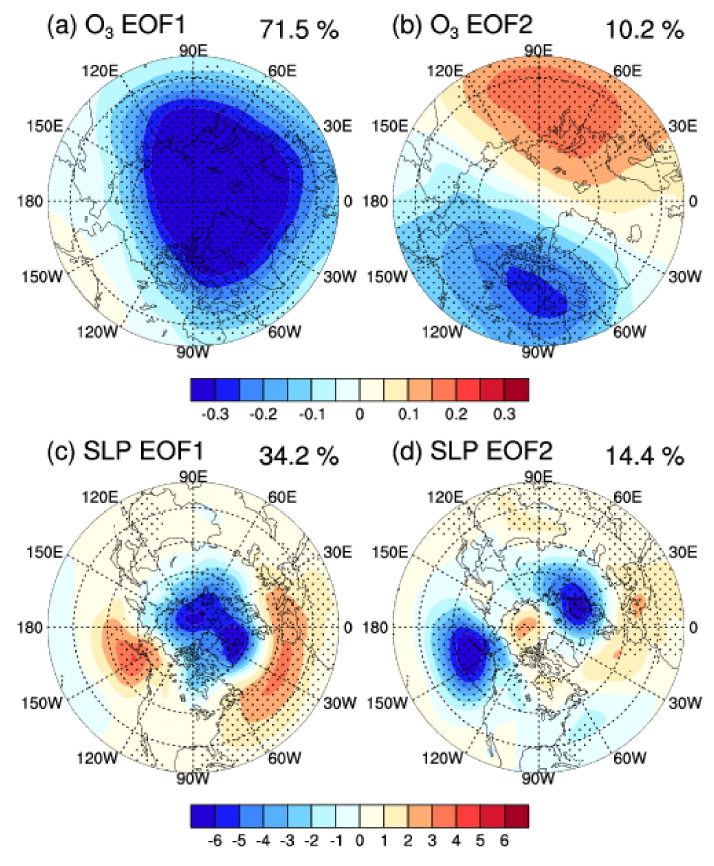
Figure 3. As in Figure 2, but for the February.